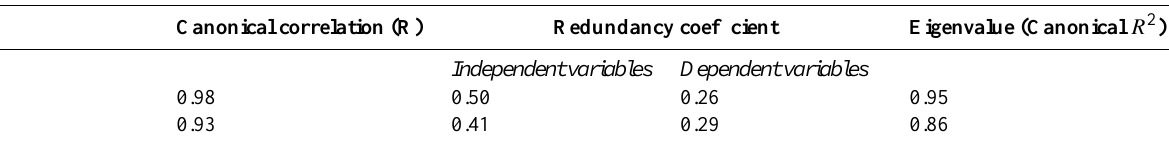
Table 4. Statistical performance of the canonical correlation analysis: canonical correlations (R), redundancy coefficients and eigenvalues are shown for the canonical variates (F1 and F2).